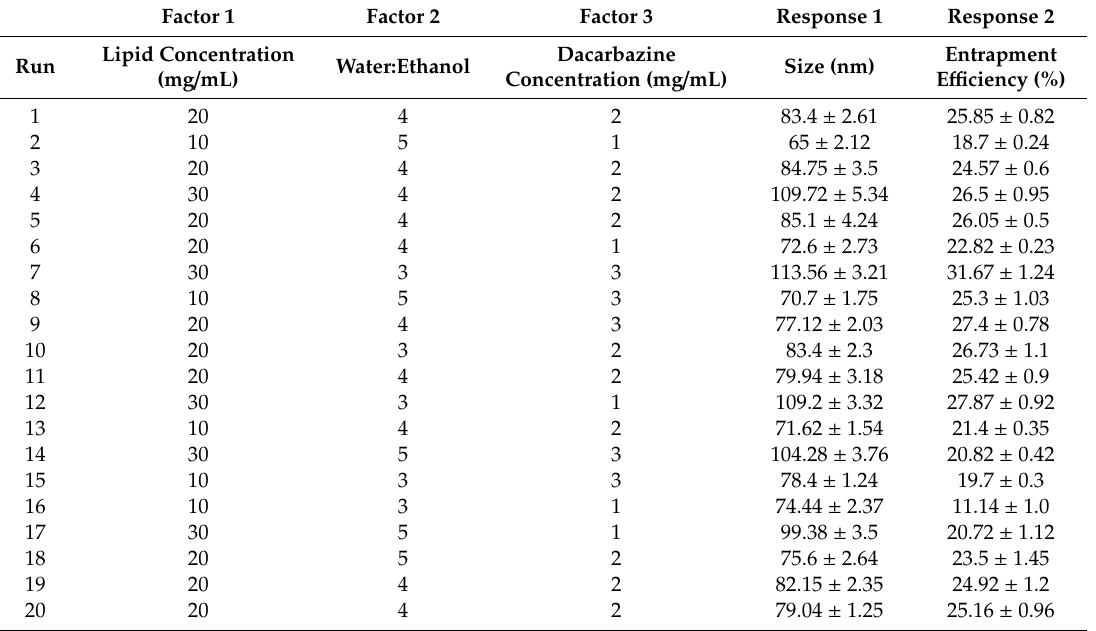
Table 4. Response Analysis Data (Level 1). Values of Response 1 and Response 2 for 20 di ff erent combinations of Factor 1, Factor 2 and Factor